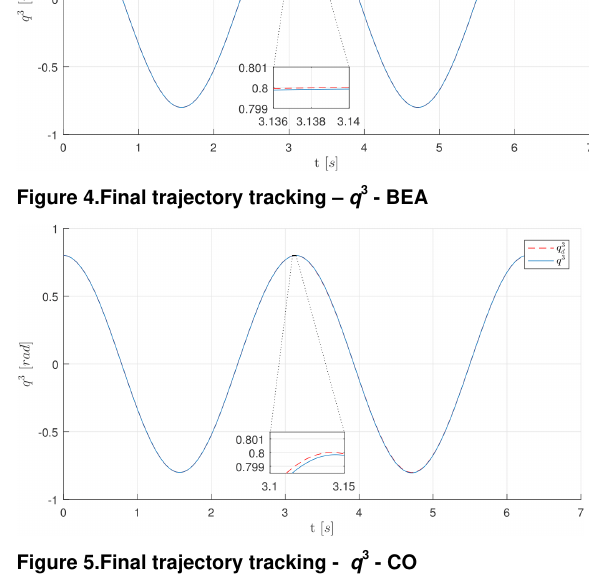
Figure 5.Final trajectory tracking - q 3 - CO